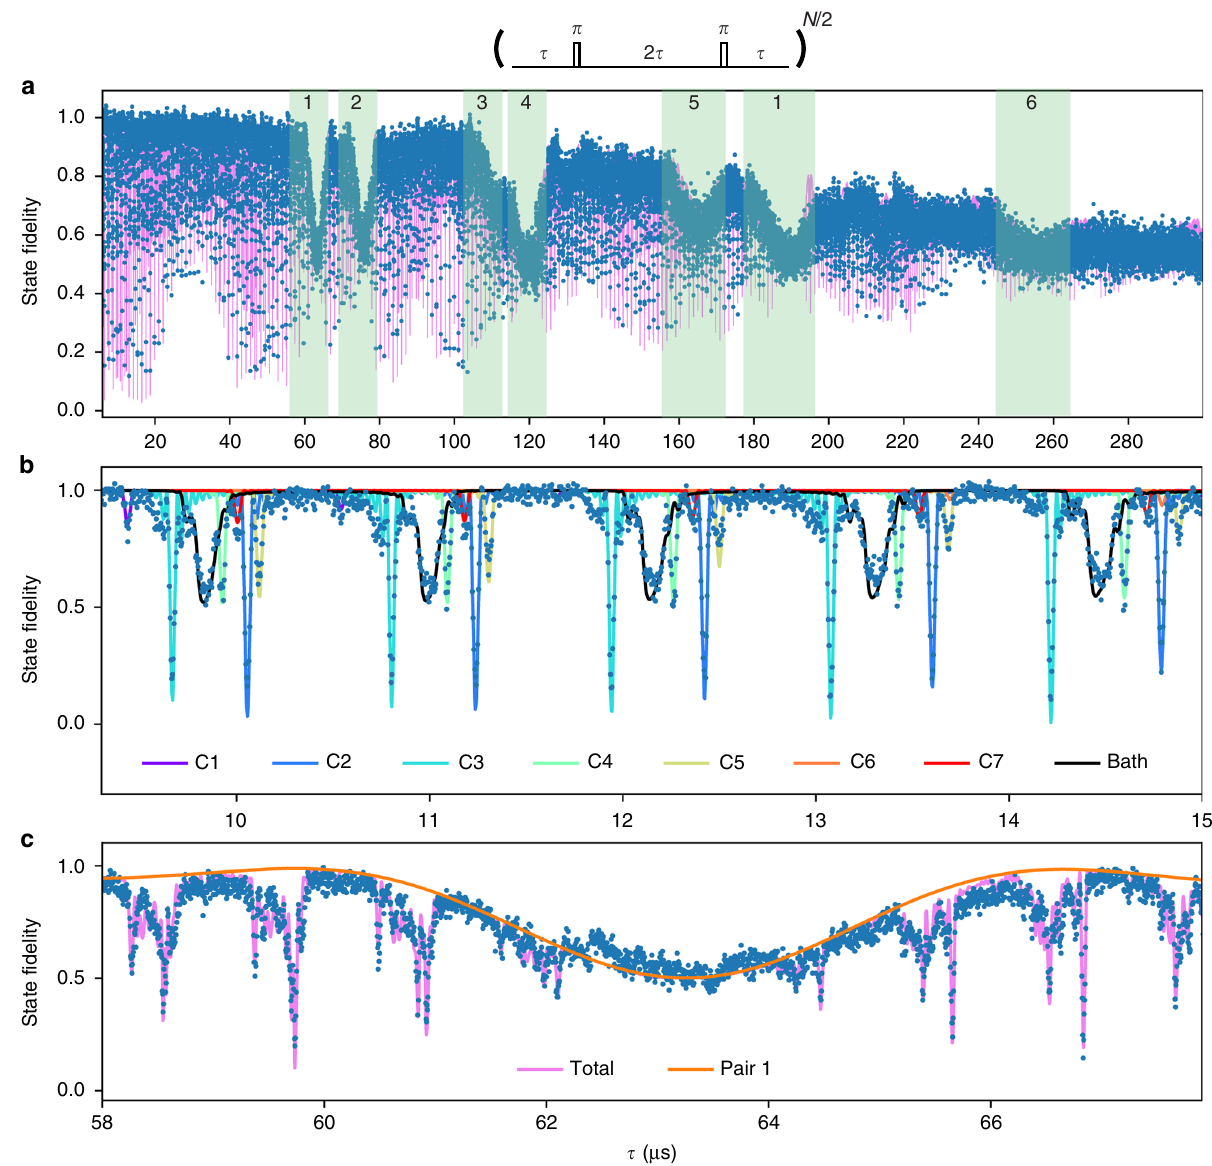
Fig. 2 Quantum sensing of the microscopic spin environment. a Dynamical decoupling spectroscopy 13 revealing a rich nuclear-spin environment consisting of individual 13 C spins, as well as pairs of coupled 13 C spins. The electron spin is prepared in a superposition, j x i ¼ ðj m s ¼ 0 i þ j m s ¼ (cid:2) 1 iÞ = decoupling sequence of N = 32 π -pulses separated by 2 τ is applied. Loss of coherence indicates the interaction of the electron spin with nuclear spins in the environment. Blue: data. Purple line: theory (see Methods). The shaded areas mark the signals due to six 13 C – 13 C pairs labeled 1 – 6. b Zoom-in showing sharp signals due to coupling to isolated individual 13 C spins 12 – 14 . The total signal is well described by seven 13 C spins (see Supplementary Table 2 for hyper fi ne parameters) and a bath of 200 randomly generated spins with hyper fi ne couplings below 10 kHz. c Zoom-in showing a broad signal due to 13 C – 13 C pair 1 16,32 . Blue: data. The solid orange line is the theoretical signal just due to pair 1, while the purple line includes the seven individual 13 C spins and the 13 C spin bath as